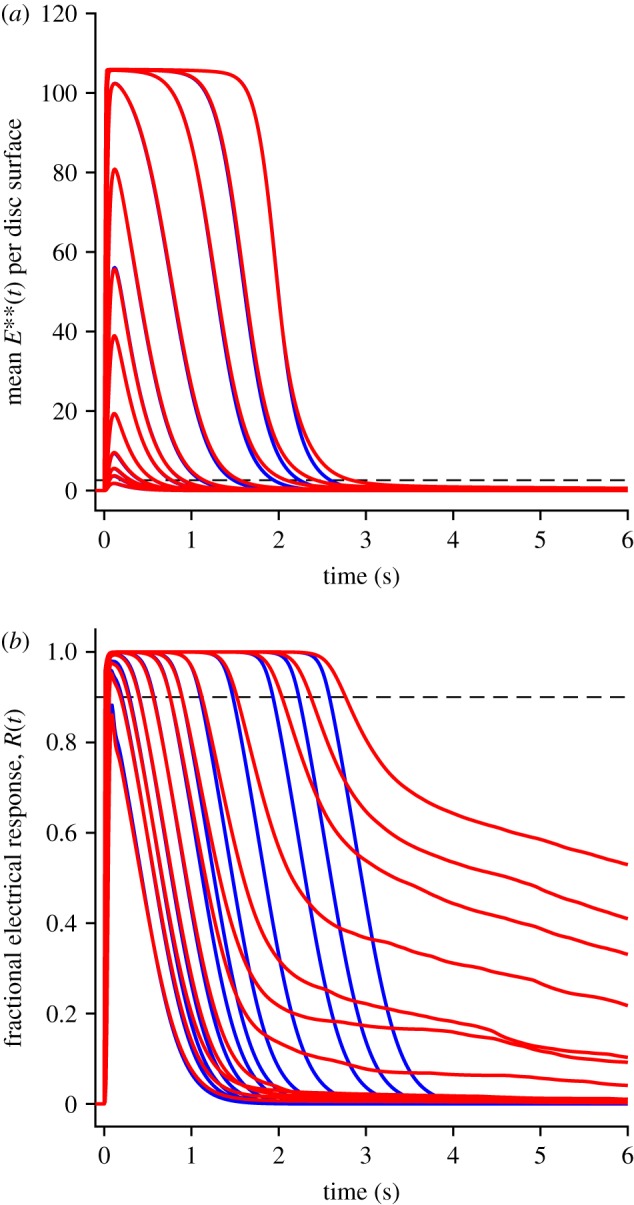
Inclusion of aberrant R* shut-off events, on slower time-base, for the same flash intensities as in figure 8. (a) Mean E** activity. (b) Electrical response. Blue traces are in the absence of aberrant events, and plot the same responses as in figure 8. Red traces are from method 3, with the inclusion of aberrant R* shut-off events occurring with a probability of 0.002, a mean lifetime of 4 s, and with activity 25% that of fully activated R*. The number of trials averaged was always at least 10, but was increased to 10 000/Φ for Φ < 1000; e.g. 50 trials averaged for Φ = 200 R*.